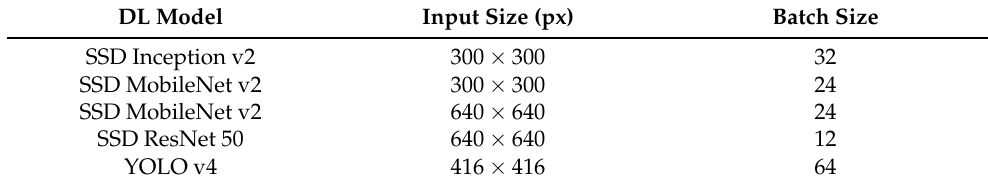
Figure 2. Representation of the transformations applied to the images. Table 5. Input and batch size for the training pipeline of the deep learning (DL) models